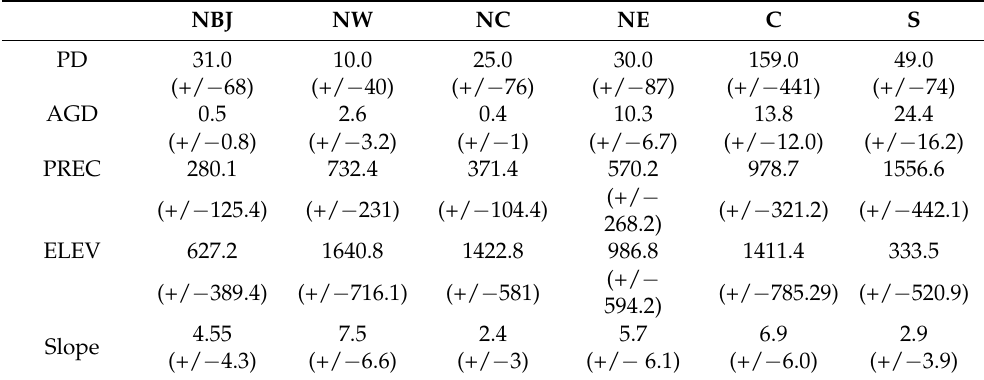
Table 1. Description of the regions of